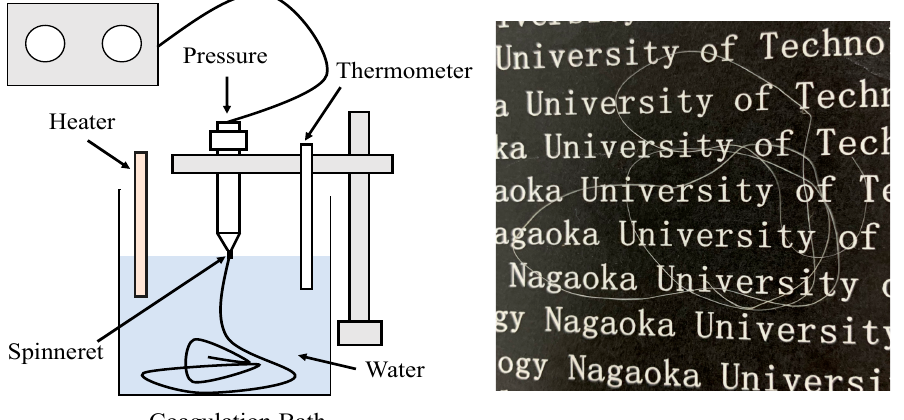
Figure 2. Formation of chitin hydrogel fiber obtained at different temperatures of the coagulation bath via the wet-spinning process and chitin hydrogel fiber.